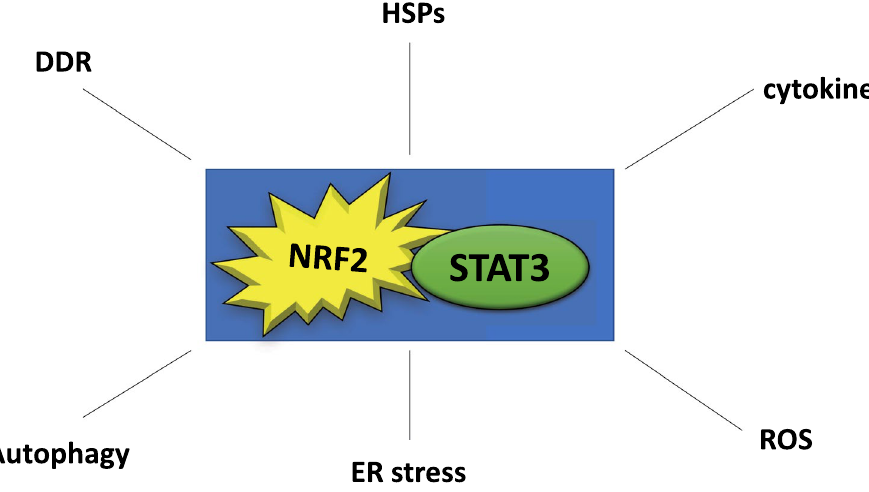
Fig. 3 Scheme illustrating how NRF2/STAT3 interplay affect multiple processes and